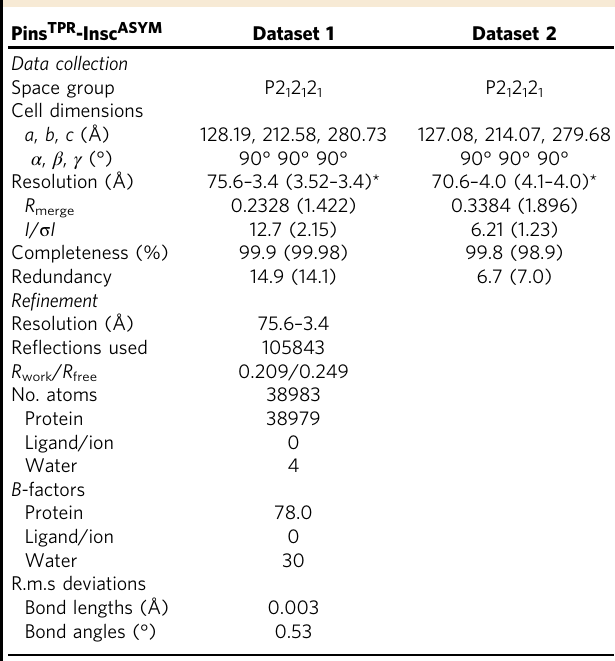
Table 1 Data collection and re fi nement